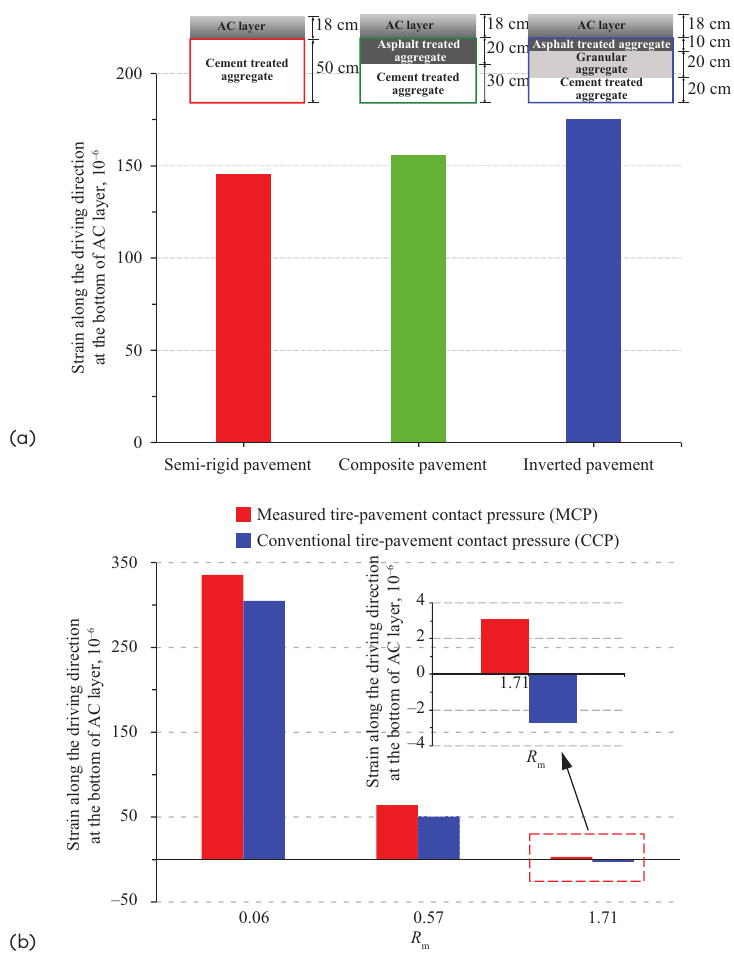
Figure 11. Strain along the driving direction at the bottom of the AC layer: (a) from field measurement presented in Wu et al. (2017); (b) from numerical simulation presented in Yue & Svec